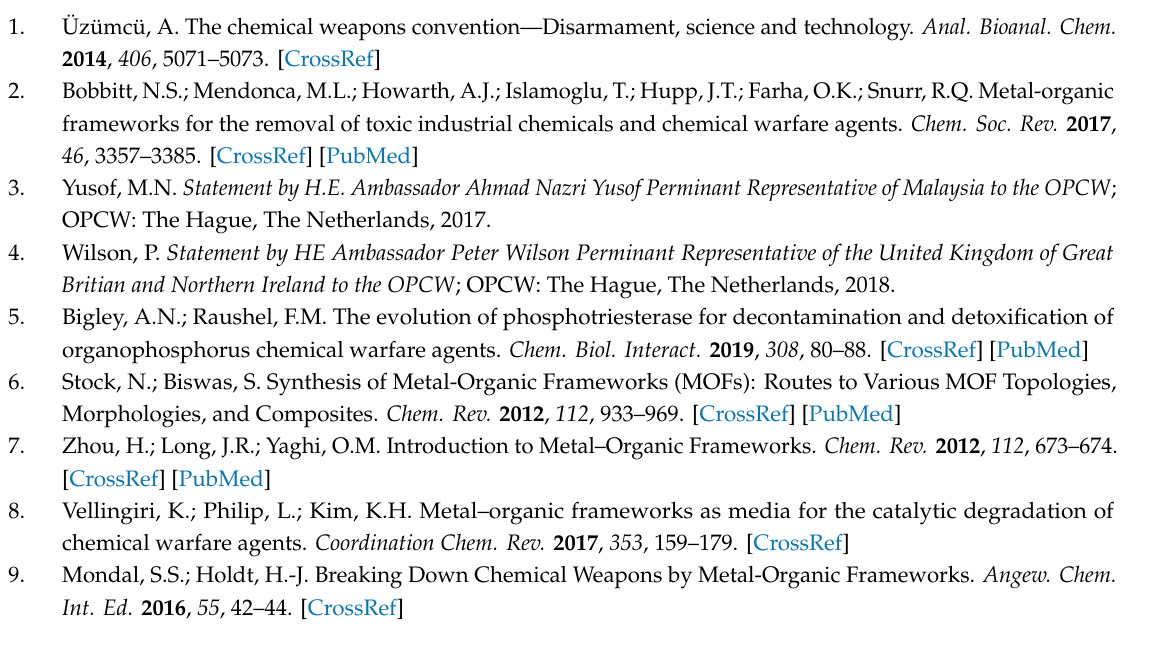
Figures S20–S23: Kinetic analysis. Table S1: Comparison of catalytic activity of